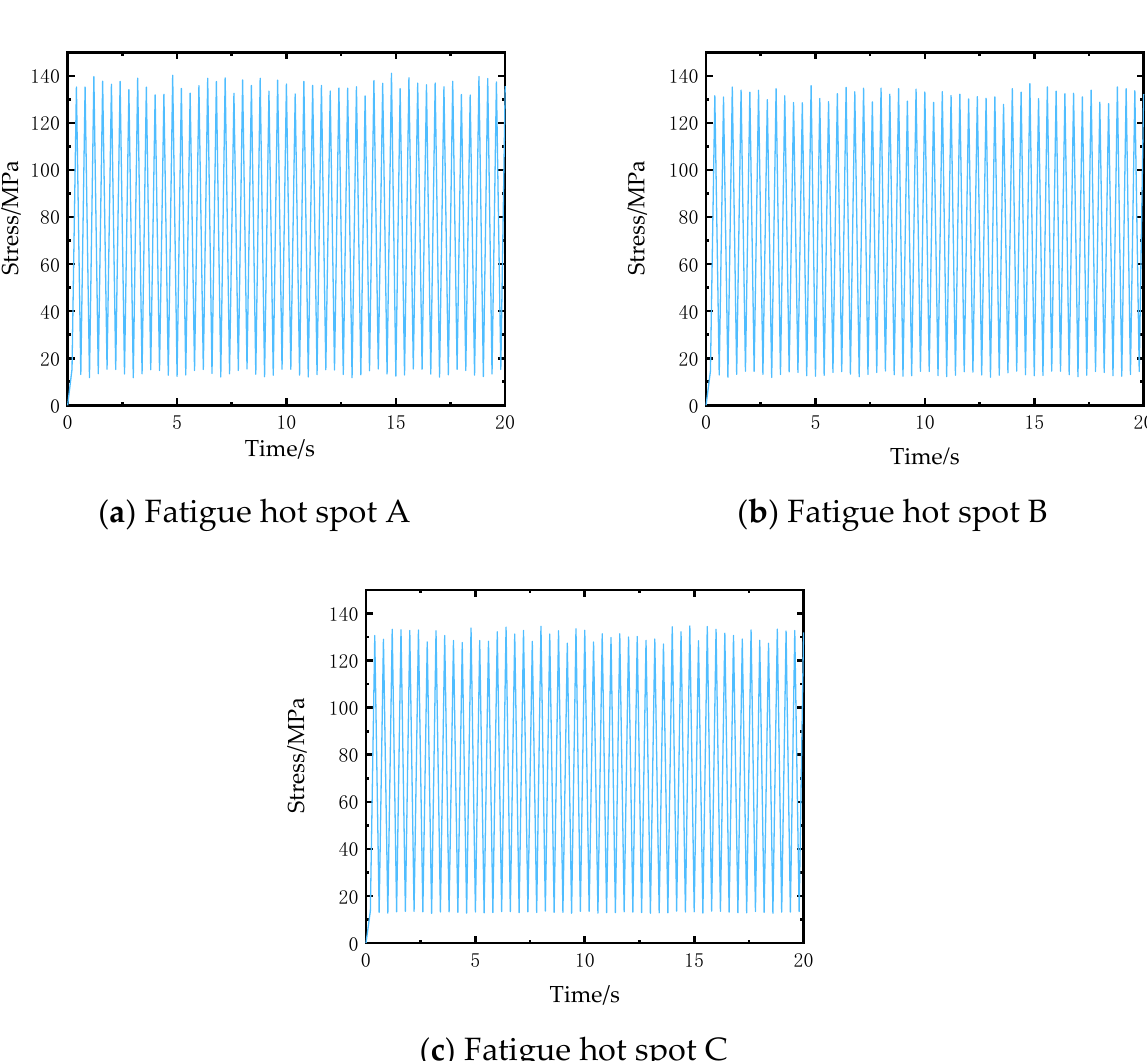
Figure 9. Stress in X direction distribution of 2D SiC/SiC stiffened plates under fatigue load.